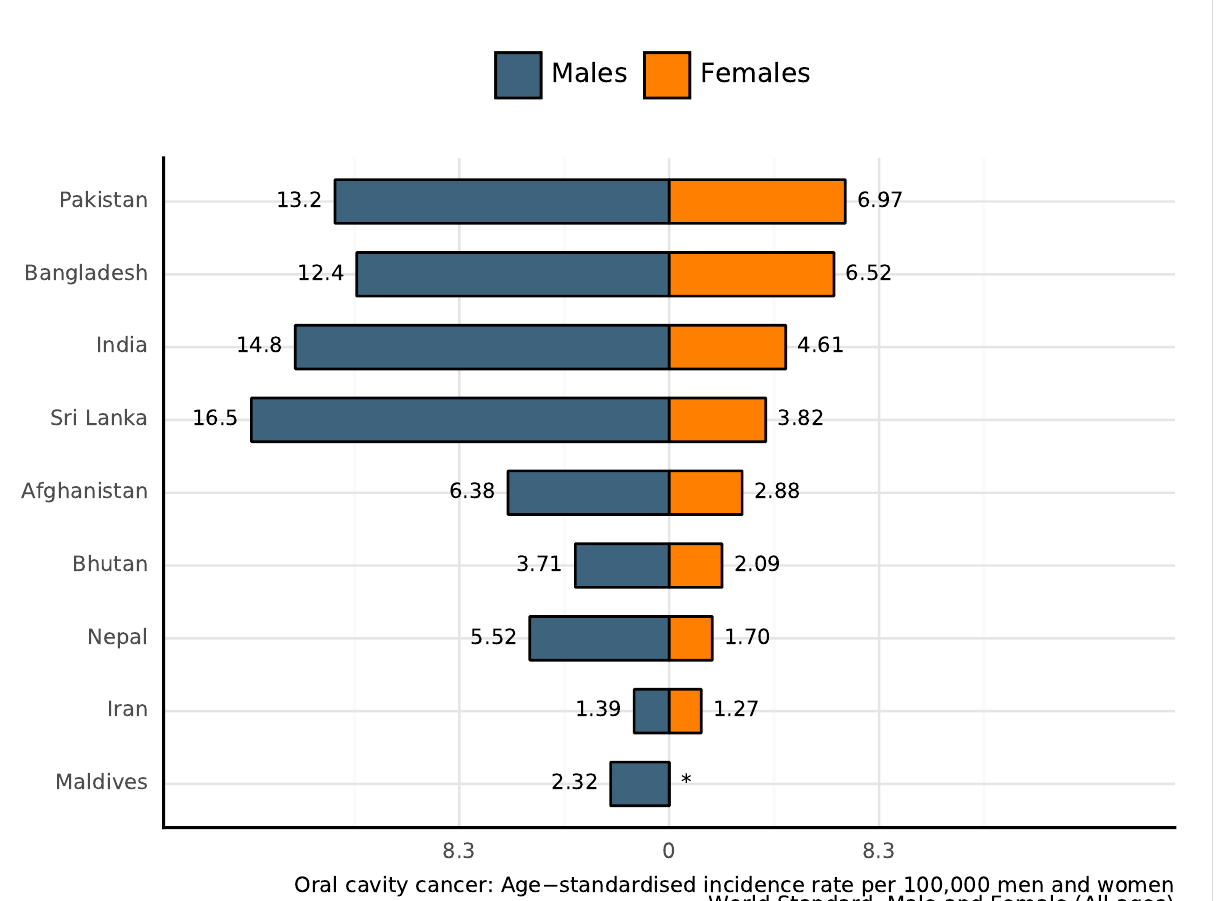
Figure 95: Age-standardised incidence rates of oral cavity cancer of India (estimates for 2020)